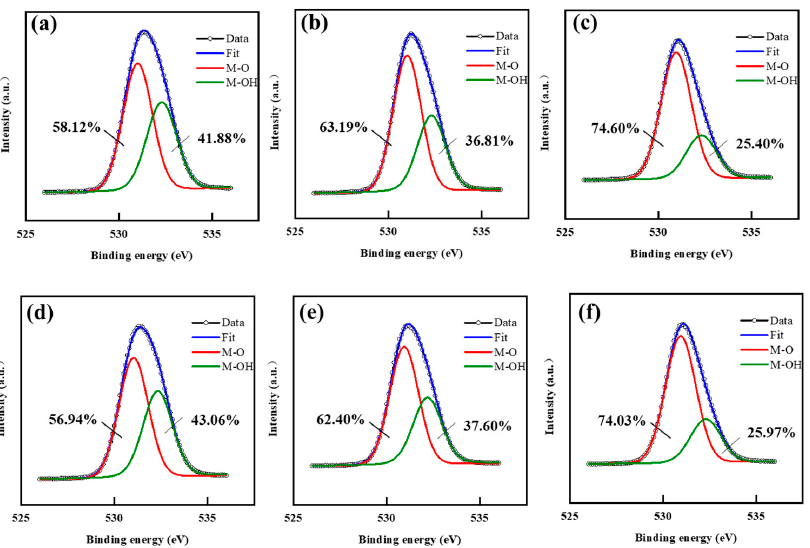
Figure 2. XPS O1s spectra of the untreated AlO x fi lms annealed at ( a ) 250, ( b ) 300, and ( c ) 350 °C; and XPS O1s spectra of the water treated AlO x fi lms annealed at ( d ) 250, ( e ) 300, and ( f ) 350 °C. The insulating properties of AlO x fi lms were evaluated with a MIM structure of ITO/AlO x /ITO. Figure 3a shows the frequency dependence of capacitance of the MIM de- vices. Interestingly, the capacitance decreases as the annealing temperature increases at lower frequency regime (<10 kHz), while it increases as the annealing temperature in- creases at higher frequency regime (>1 MHz). In addition, the capacitance of the MIM devices annealed at 250 or 300 °C depends on the frequency greatly, while the AlO x film annealed at 350 °C is almost independent of the measuring frequency (when the measur- ing frequency is lower than 100 kHz). The areal capacitances at 1 kHz for the MIM devices annealed at 250, 300, and 350 °C are 179.1, 166.3, and 148.1 nF/cm 2 , respectively; and the areal quasistatic (QS) capacitances (see Figure 3b) for the devices annealed at 250, 300, and 350 °C are 288.9, 263.4, and 152.8 nF/cm 2 , respectively. It shows that the areal quasistatic capacitance of the MIM devices annealed at 250 or 300 °C is much higher than those meas- ured at 1 kHz, while there is no much difference between the areal quasistatic capacitance and the areal capacitance at 1 kHz for the one annealed at 350 °C. The strong frequency- dependent capacitance of the MIM devices annealed at 250 or 300 °C is attributed to re- laxation polarization of the weakly bound ions in the incompletely decomposed AlO x films. Especially, the protons (H + ), which can move in the whole AlO x fi lm, move to the ITO/AlO x interface and form an electric double layer (EDL) that has ultrahigh capacitance at very low frequency [24,25].